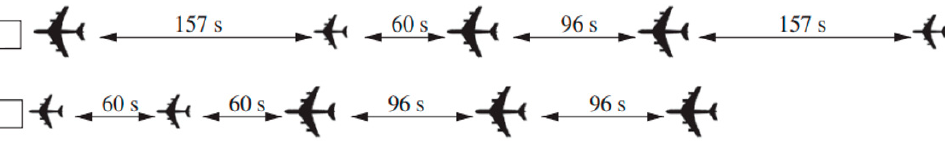
Figure 1. E ff ects on runway throughput of the optimal aircraft sequence [7]. Figure 1. Effects on runway throughput of the optimal aircraft sequence